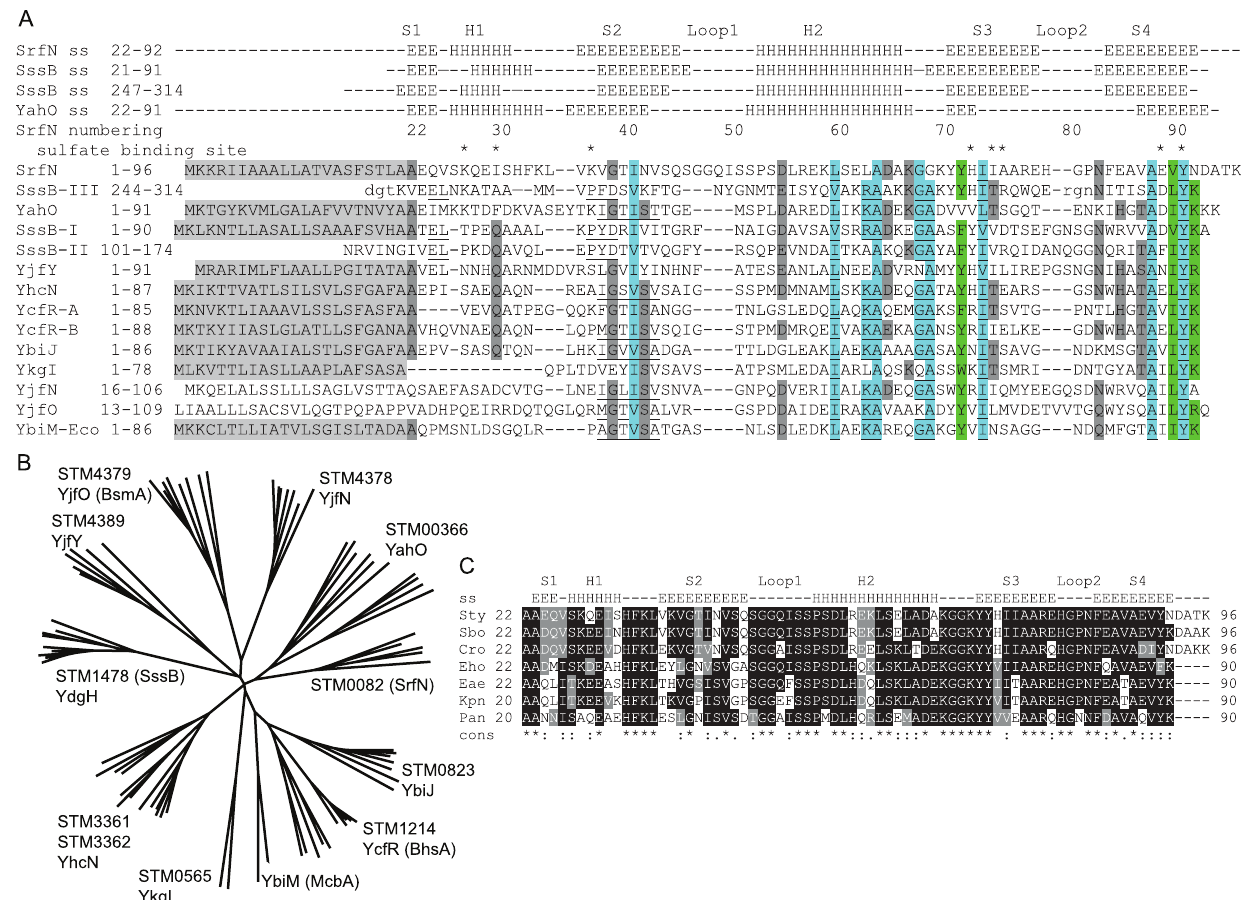
Figure 1. DUF 1471 sequences. A : Multiple sequence alignment of DUF1471 paralogues from S. Typhimurium, as well as E. coli YbiM, for which there is no close homolog in Salmonella . Alignment of SrfN, YahO, SssB-I and SssB-III is structure-based over the entire structured sequence (SrfN residues 22–91), other alignments are sequence-based and are between core regions only (SrfN residues 35–91) because sequence identity to SrfN residues 22–38 is low and alignments in this region are uncertain. Secondary structure in SrfN, YahO, SssB-I, and SssB-III is indicated above: E=extended ( b -sheet) structure, H=helix. The core residues of the sulfate-binding motif in SrfN are indicated with asterisks. Conserved sequence motifs identified by Rudd [1] are underlined. Other conserved residues are highlighted in green or dark grey. Two notable loop regions in the structure are also indicated. SrfN and YahO both have C-terminal tag sequences LEHHHHHH that are not shown. Light grey highlighted portions indicate likely signal sequences for periplasmic localization that are known or likely to be cleaved by a signal peptidase. In the case of SrfN and YahO, the signal sequence was proven experimentally to be cleaved during heterologous expression in E. coli . Inter-domain regions of SssB are not shown. Lower case letters in SssB-III (C-terminal domain) indicate residues with missing electron density in the X-ray structure. Highly conserved residues are indicated by highlighting (blue=hydrophobic, green=polar), somewhat conserved residues are indicated with grey highlighting. The following sequences are listed ( S. Typhimurium LT2 locus and UniProt/TrEMBL numbers in parentheses): SrfN (STM0082/Q7CR88), YjfY (STM4389/Q8ZK84), YhcN (STM3361/Q8ZLP6), YcfR seq. I (STM1214/Q8ZQ03), YcfR seq. II (STM3362/Q7CPN0), YahO (STM0366/Q7CR49), YbiJ (STM0823/Q7CQW3), YkgI (STM0565/Q7CR04), YjfO (STM4379/Q8ZK92), YjfN (STM4378/Q8ZK93), SssB (STM1478/Q8ZPL1), YbiM/McbA ( E. coli , P0AAX6). B : Unrooted phylogenetic tree (phylogram) constructed from ten diverse genera from the Enterobacteriaceae. Major branches containing Salmonella and E. coli subfamily members are indicated. C : Multiple sequence alignment of SrfN homologues: a subfamily of DUF1471 proteins. For each sequence and abbreviated organism name listed, the full genus and species name, protein/ORF name, database accession number, and similarity to SrfN, excluding the signal sequence, are as follows: Sty, Salmonella enterica Typhimurium, STM0082 (SrfN), NP_459087 and many other Salmonella strains; Sbo, Salmonella bongori , SBG_0068, YP_004728986 (93%); Cro, Citrobacter rodentium , ROD_12311, YP_003364817 (80%); Eho, Enterobacter hormaechei , HMPREF9086_0329, ZP_08496071 (65%); Eae, Enterobacter aerogenes EAE_13230, YP_004592839 (70%); Kpn, Klebsiella pneumonia , KPK_4095, YP_002239898 (68%); Pan, Pantoea sp., Pat9b_3745, YP_004117591 (61%). Notes: Other Salmonella, Klebsiella, and Enterobacter species and strains contain identical or nearly identical sequences to the representatives shown here. However, some Pantoea species do not contain homologues that fall within this DUF1471 subfamily.